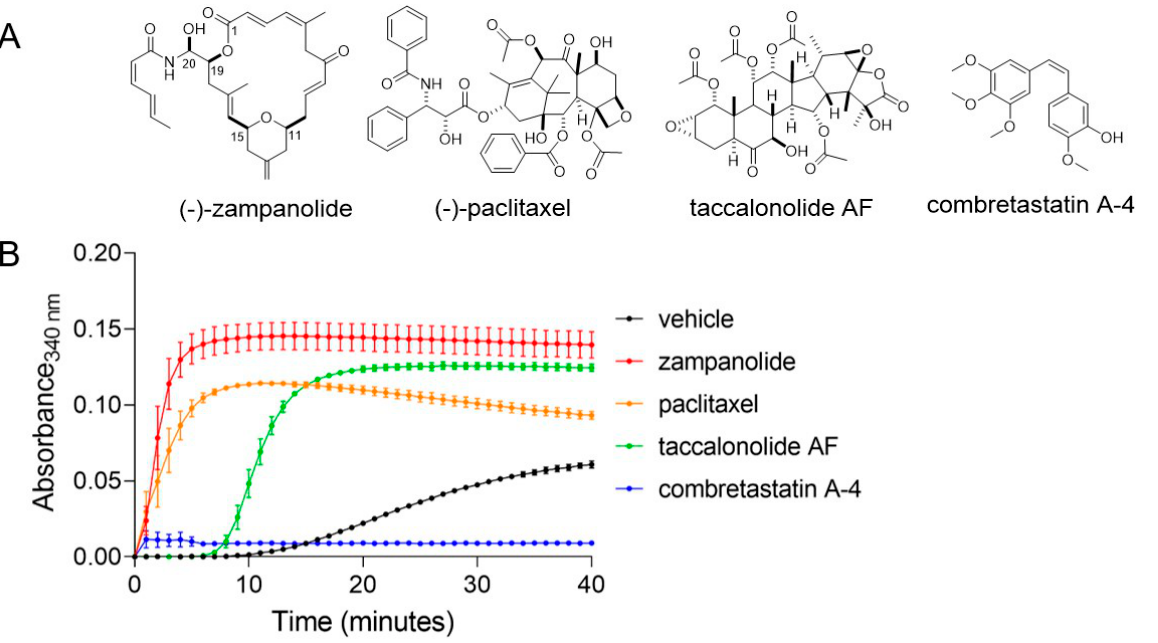
Figure 1. ( A ) Chemical structures of compounds. ( B ) Polymerization of purified porcine tubulin (20 µM) with DMSO vehicle or 20 µM zampanolide, paclitaxel, taccalonolide AF or combretastatin A- 4. Polymerization was measured by the absorbance at 340 nm every minute for 40 min. N = 2 ±